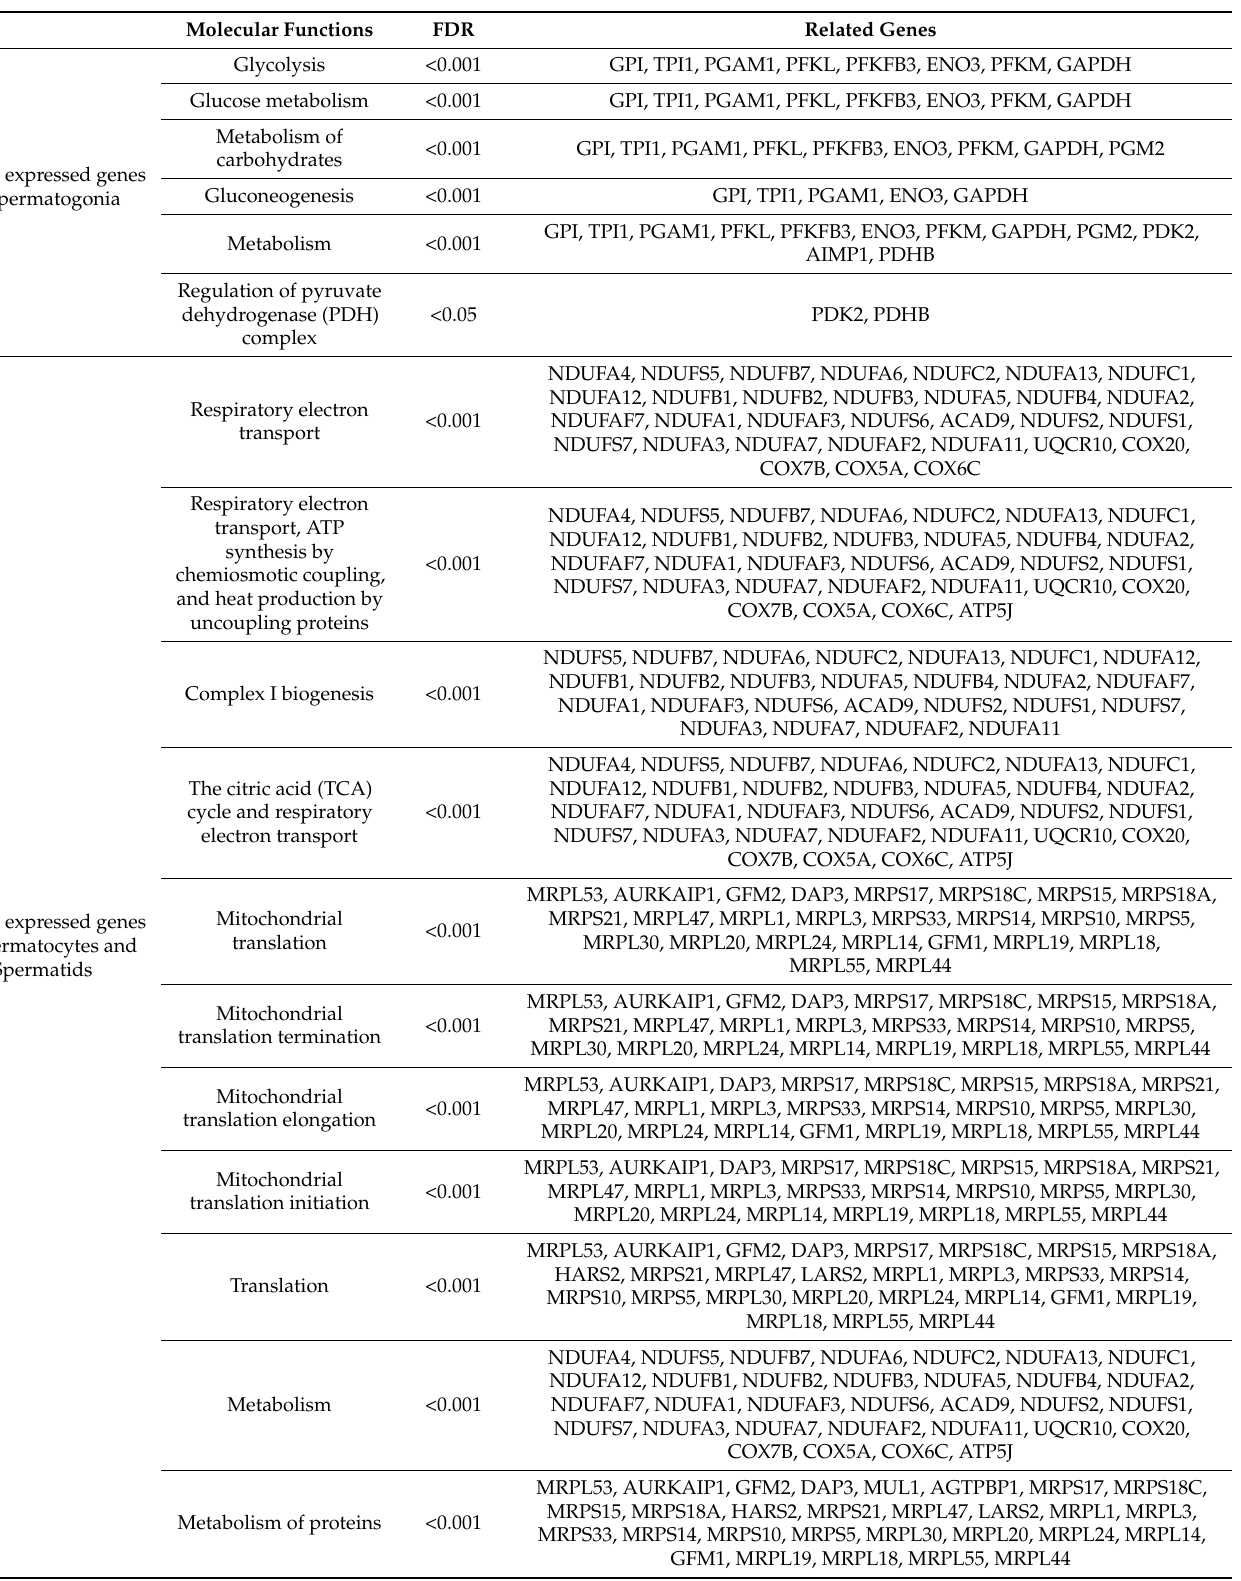
Table 2. Summary signaling pathways based on differentially expressed genes in male germ cells during